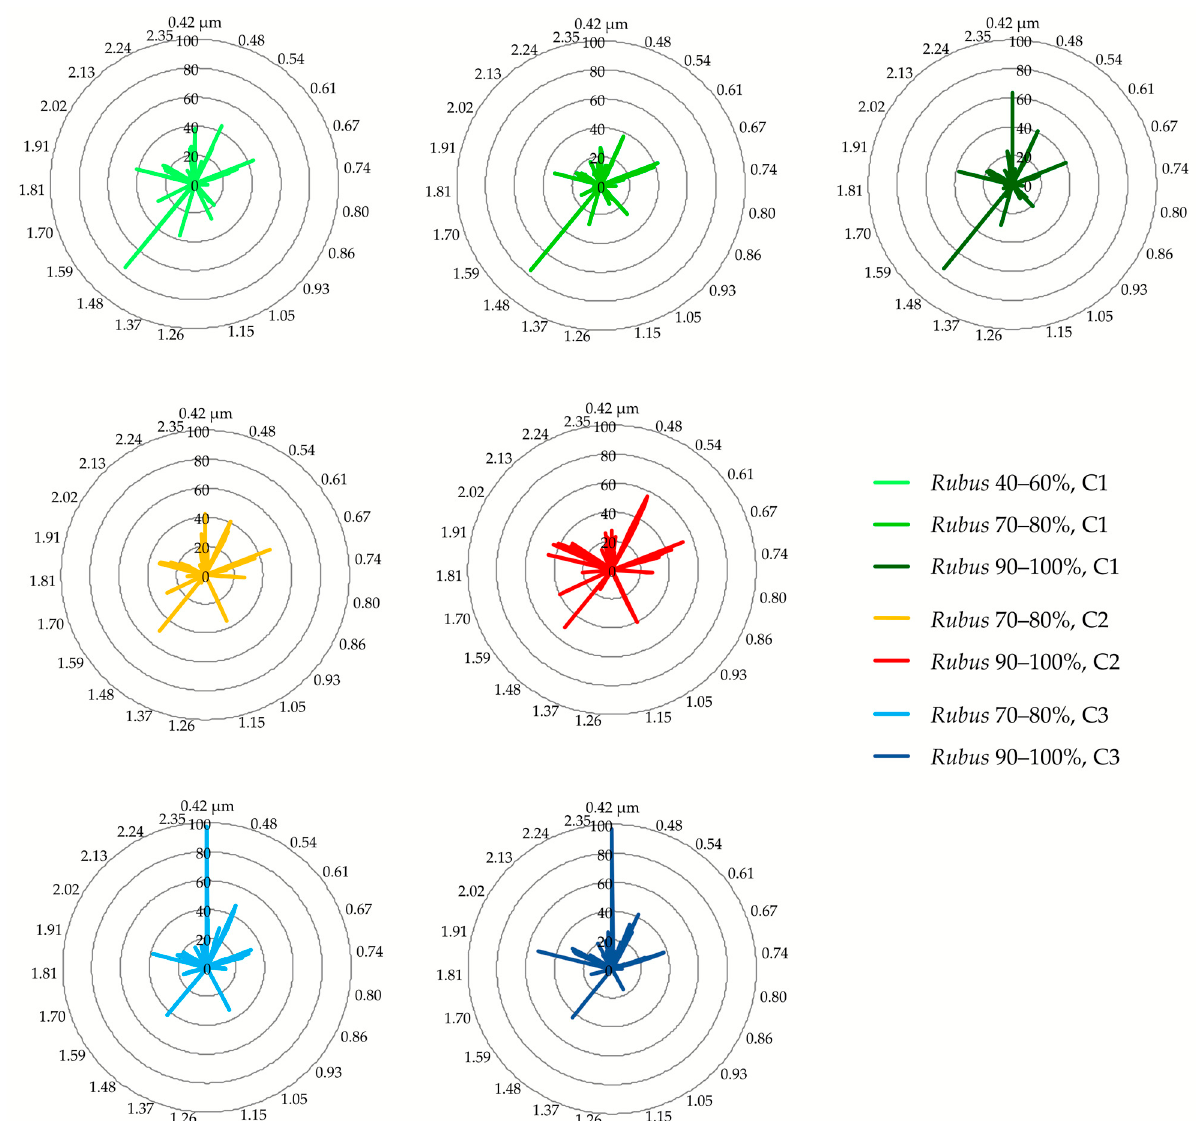
Figure 5. The frequency of the occurrence of each spectral band differentiating varied Rubus caesius coverage and campaigns calculated based on 100 iterations of the Linear Discriminate Analysis (LDA) analysis.